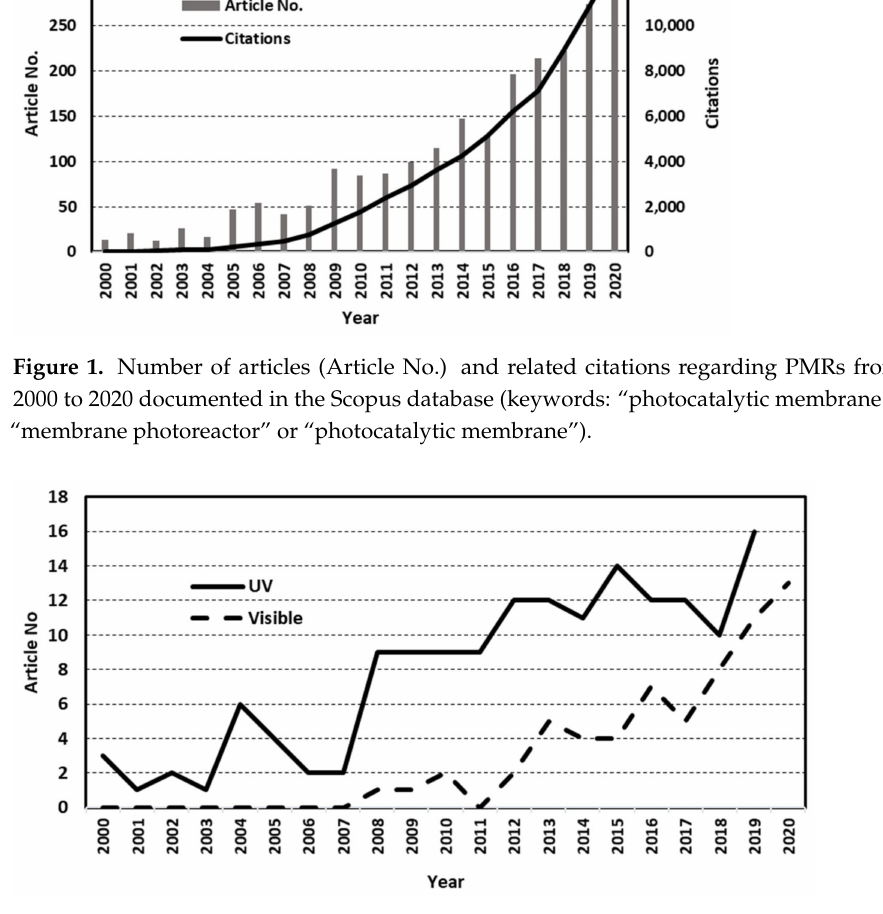
Figure 2. Number of articles (Article No.) on the application of PMRs by using UV or visible light related to citations from the year 2000 to 2020 documented in the Scopus database (keywords: “photocatalytic membrane reactor and UV” or “photocatalytic membrane reactor and